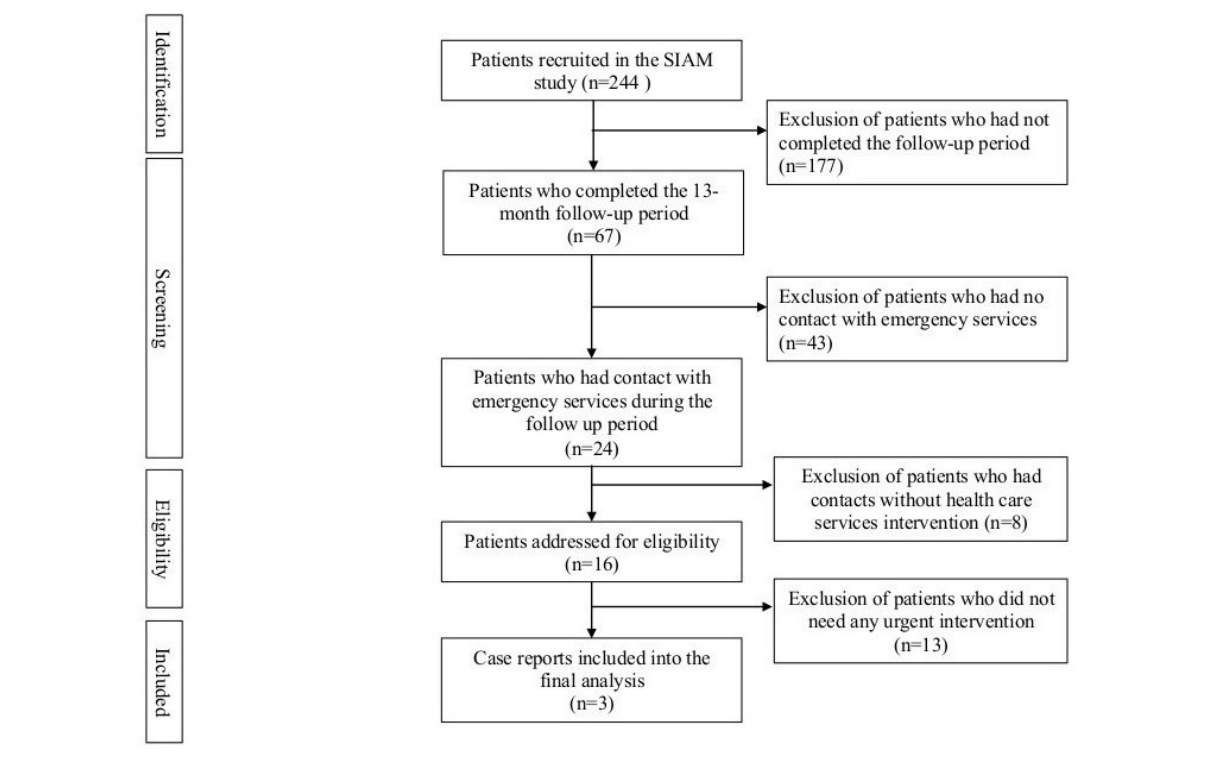
Figure 1. Flow of patient selection process.